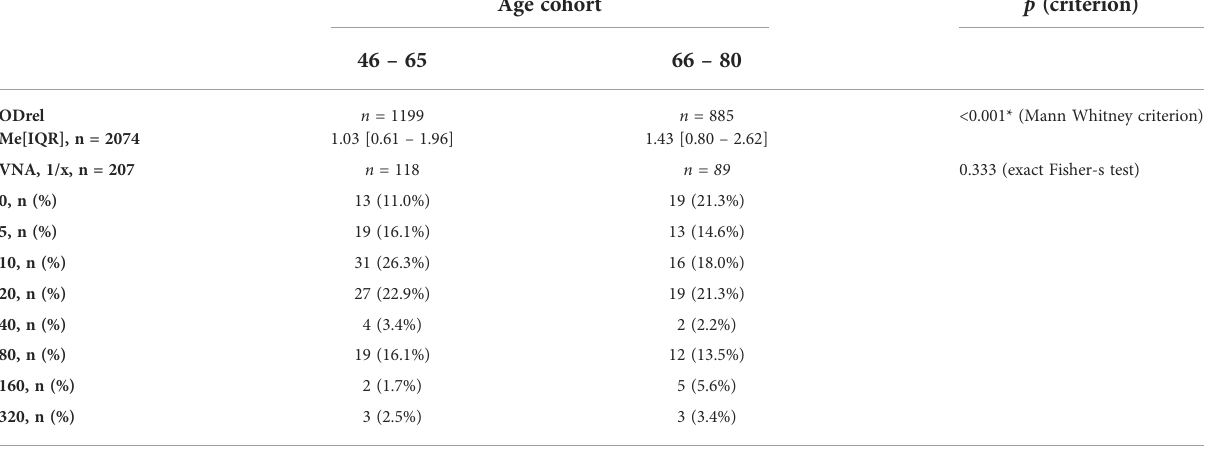
TABLE 6 The level of antibodies and VNA in the age cohorts 46-65 and 66-80